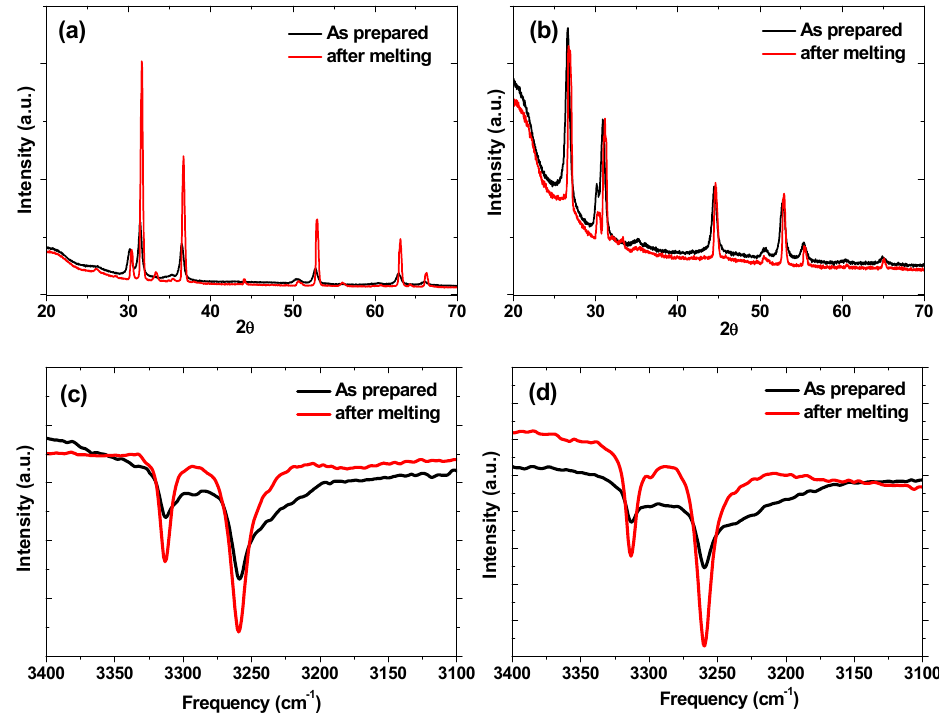
Figure 4. ( a ) XRD pattern of LiNH 2 -KH sample before and after DSC measurement. ( b ) XRD pattern of LiNH 2 -NaH; ( c ) FTIR spectra of LiNH 2 -KH sample; ( d ) FTIR spectra of LiNH 2 -KH sample.